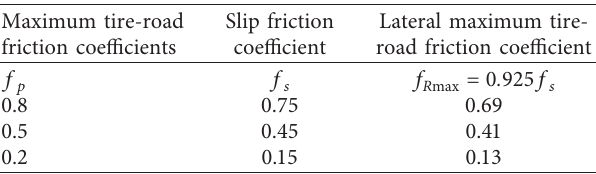
Table 4: The maximum tire-road friction coefficients, slip friction coefficient, and lateral maximum tire-road friction coefficient [32–34].